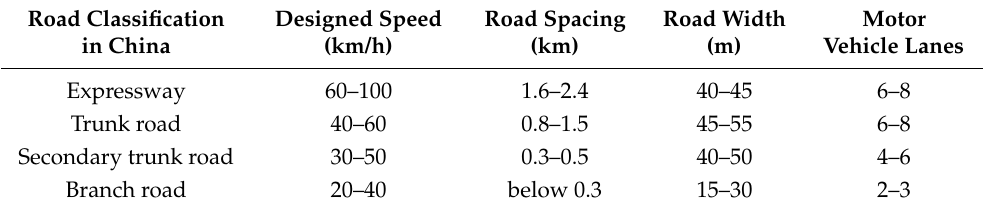
Table 1. Classification of the four types of urban roads